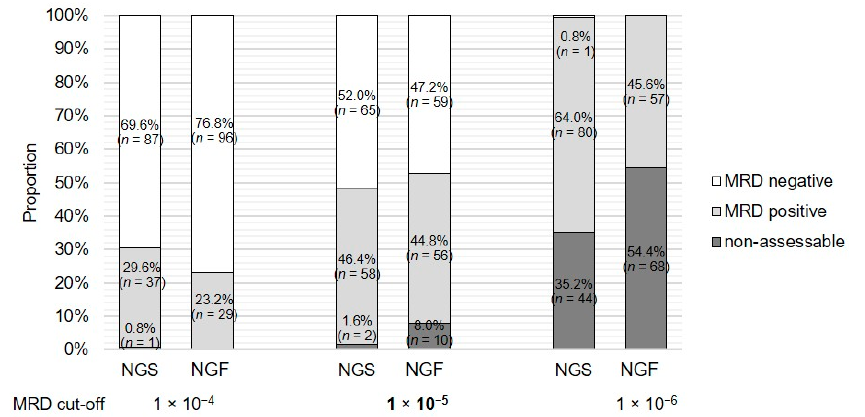
Figure 2. MRD rates based on different MRD cut-offs and key metrics from NGS and MFC analyses.